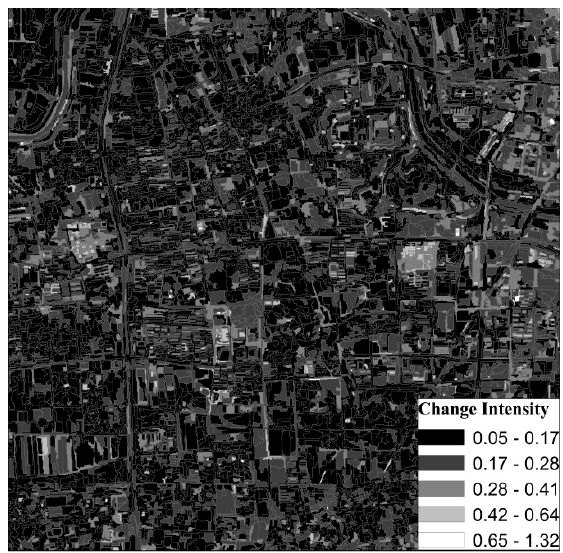
Figure 12. Change intensity map for the GF-1 images in 2016 and 2017.